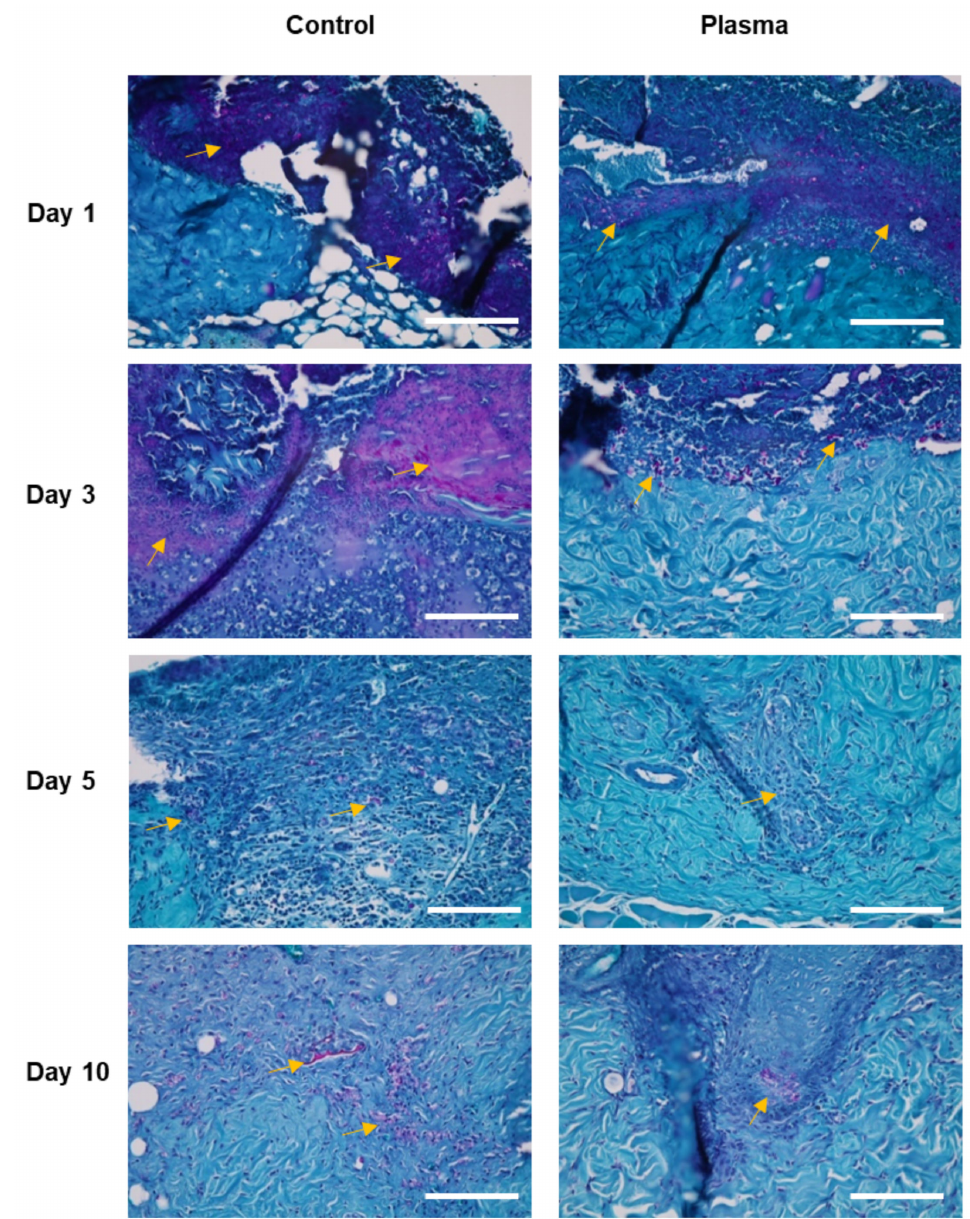
Figure 9. Representative histological images of the skin wound of diabetic rat infected with C. albicans stained with periodic acid-Schiff. Fungal infection (yellow arrows, cell stained with magenta) was more prominent in the control group compared to the plasma-treated group. Original magnifica- tion × 40; scale bars = 200